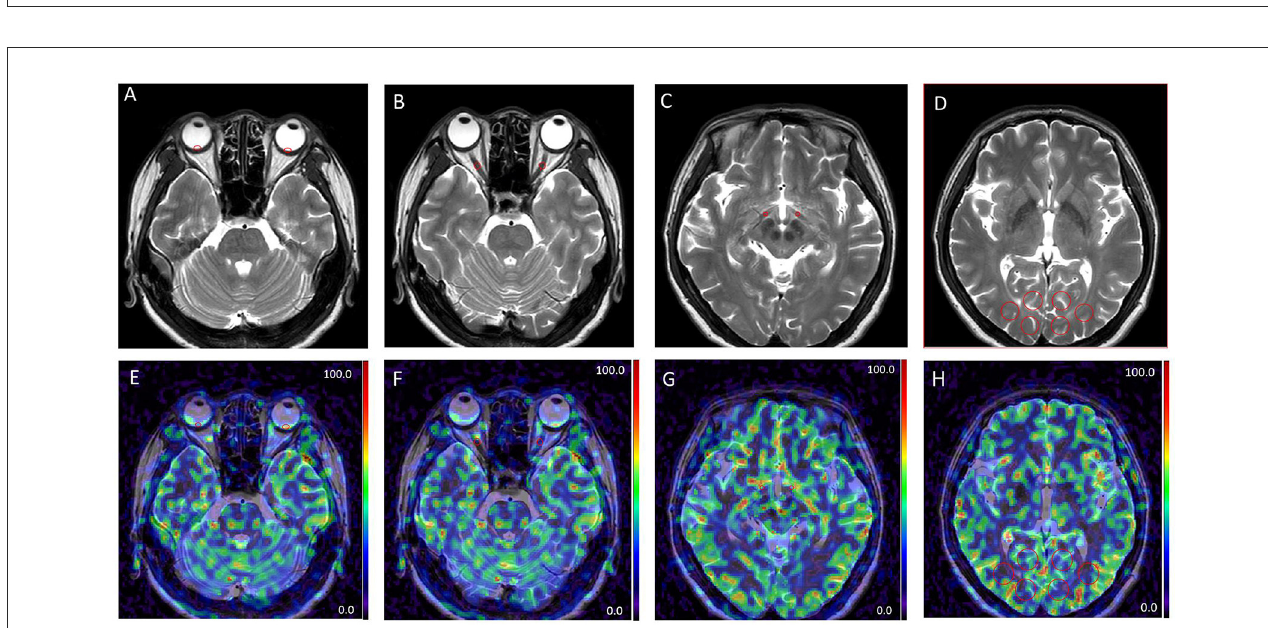
FIGURE2 Examples of different patterns in MRI images. T2 weighted images (A–D) . Arterial spin labeling (ASL) images at post-labeling delay (PLD) of 1.5s (E–H) . Regions of interest derived from the retinal-choroidal complex (A, E) ; the intraorbital segments of the optic nerve (B, F) ; the tractus opticus (C, G) ; the visual center (D, H) ; ROIs were all marked by red circles.